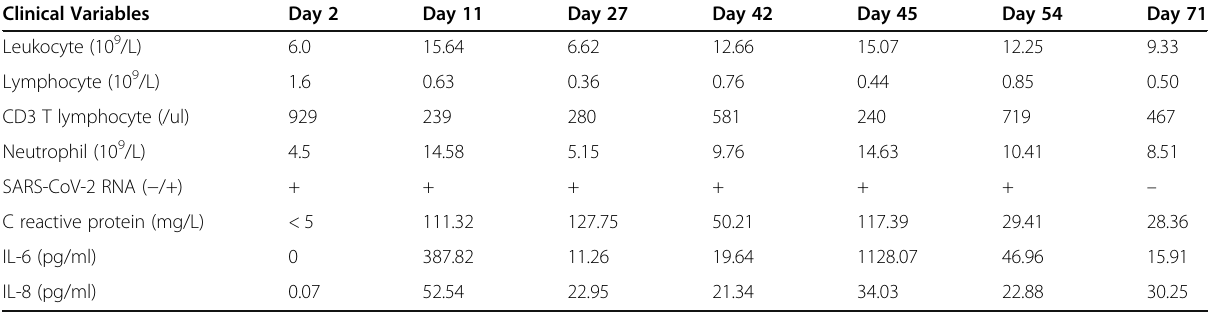
Table 1 Basic clinical parameters during hospitalization Clinical